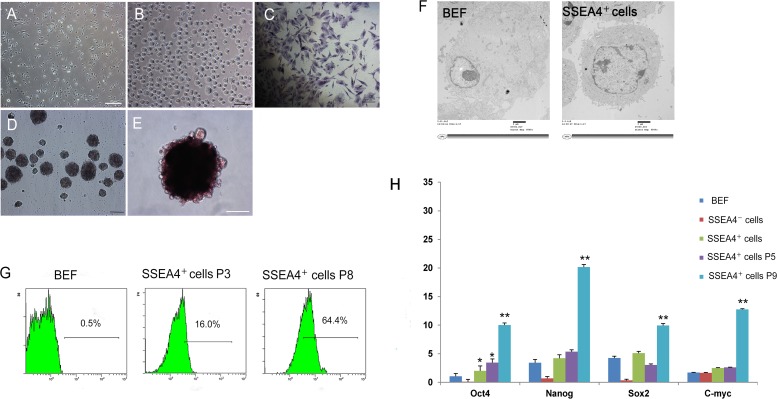
Isolation of SSEA-4+ cells.(A) SSEA-4+ cells at P1, were isolated from bovine fetal skin fibroblasts by MACS. (B) SSEA-4+ cells demonstrate a rough surface and a long cilium. (C) Positive AP staining of SSEA-4+ cells. (D) Floating spheres of SSEA-4+ cells in suspension culture for 3 days. (E) AP staining of cell clusters from SSEA-4+ cells. (F) TEM of BEF and SSEA-4+ cells. (G) Flow cytometry analysis exhibiting the percentage of BEF, SSEA-4+ cells at P3, and SSEA-4+ cells at P8 that expressed Oct4. (H) qRT-PCR analysis of OCT4, NANOG, SOX2, and C-MYC gene expression in BEF, SSEA-4− cells, SSEA-4+ cells at P1, SSEA-4+ cells at P5, and SSEA-4+ cells at P9. All data are presented as the mean±SEM and are derived from three independent experiments (*P<0.05; **P<0.01). A: Scale bar = 100 μm; B-E: Scale bar = 50 μm.